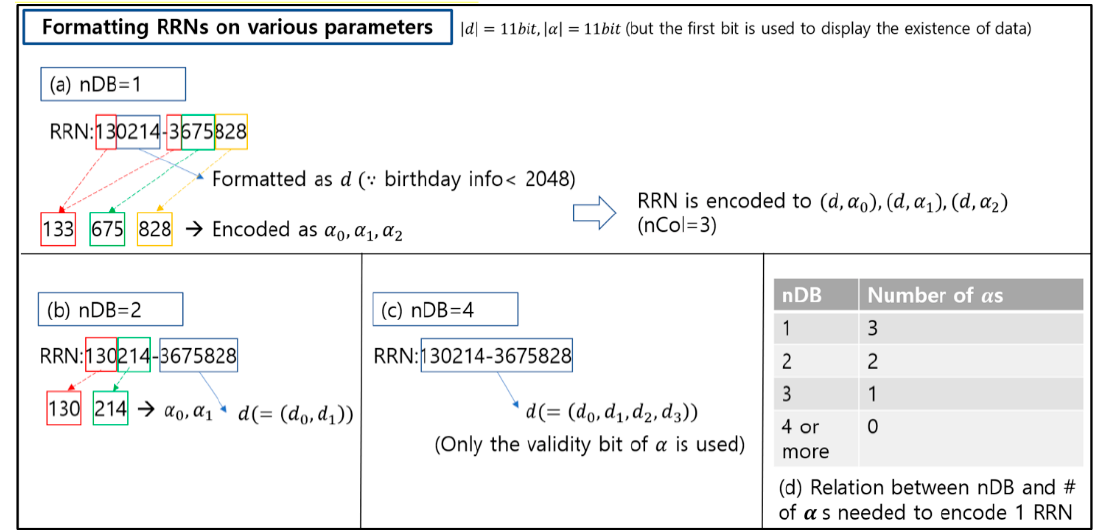
Figure 4. Formatting residence registration numbers (RRNs) on various parameters (when nDB = 1, 2, 3, 4).